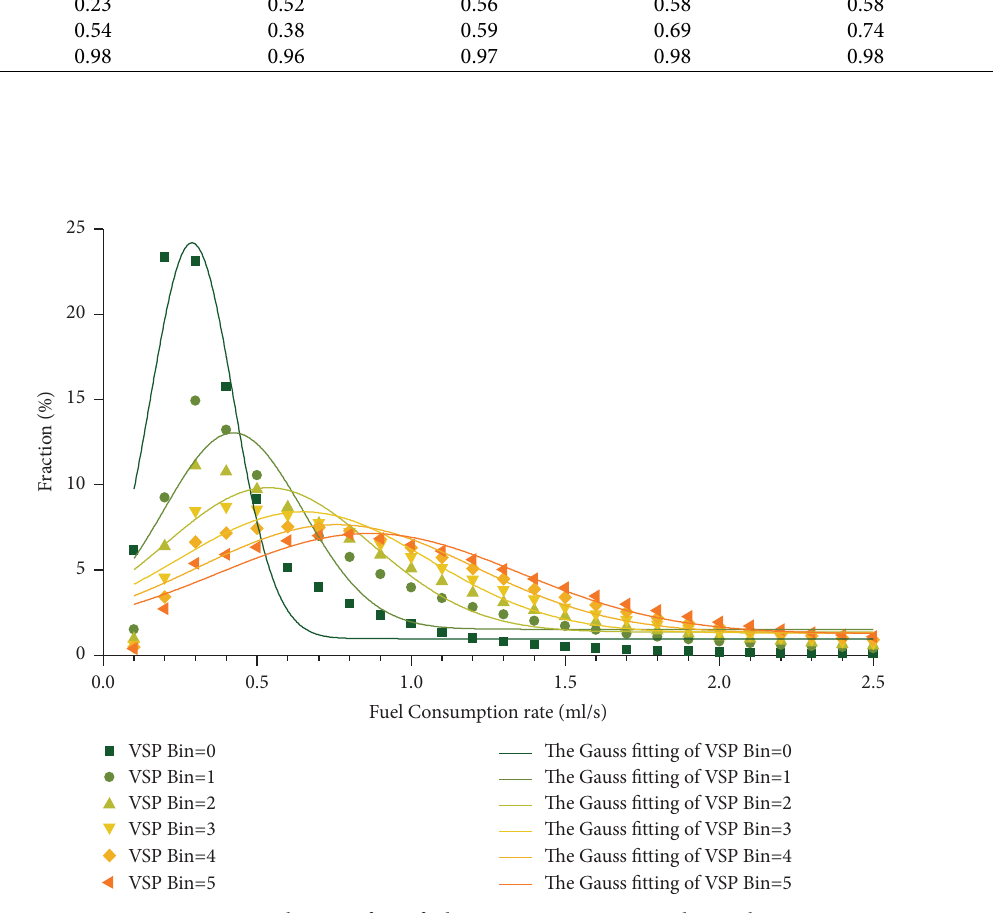
Figure 5: Distribution of CV fuel consumption rate in each VSP